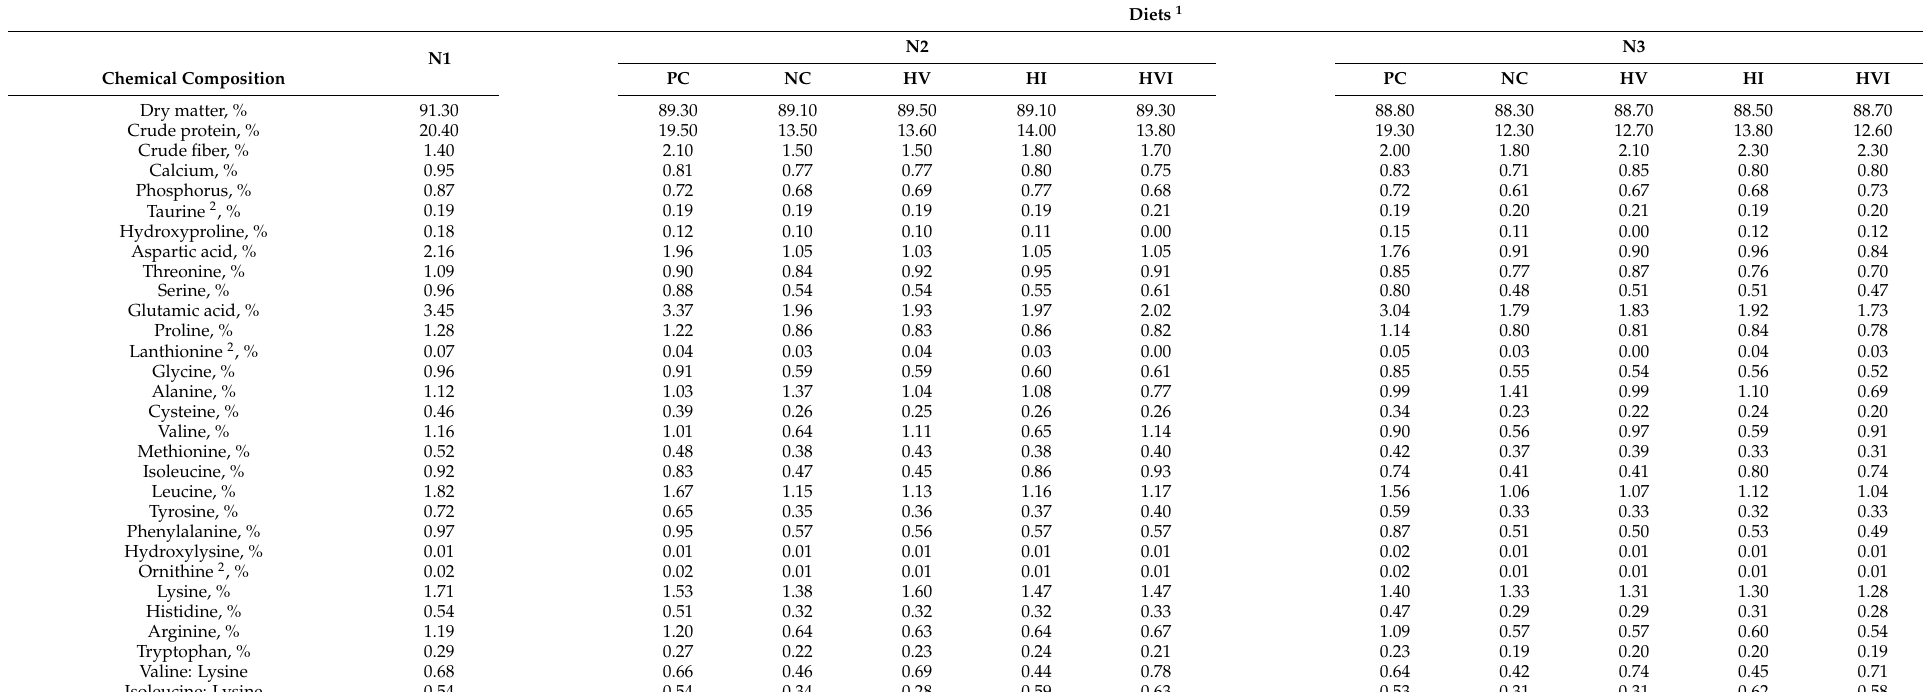
Table 2. Analyzed chemical composition of experimental diets (as-fed